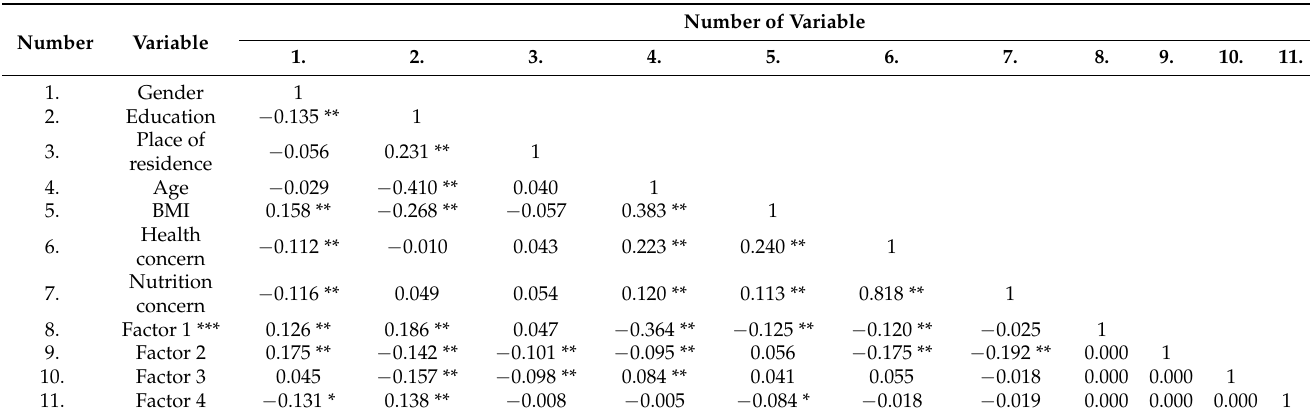
Table 5. Bivariate correlations between